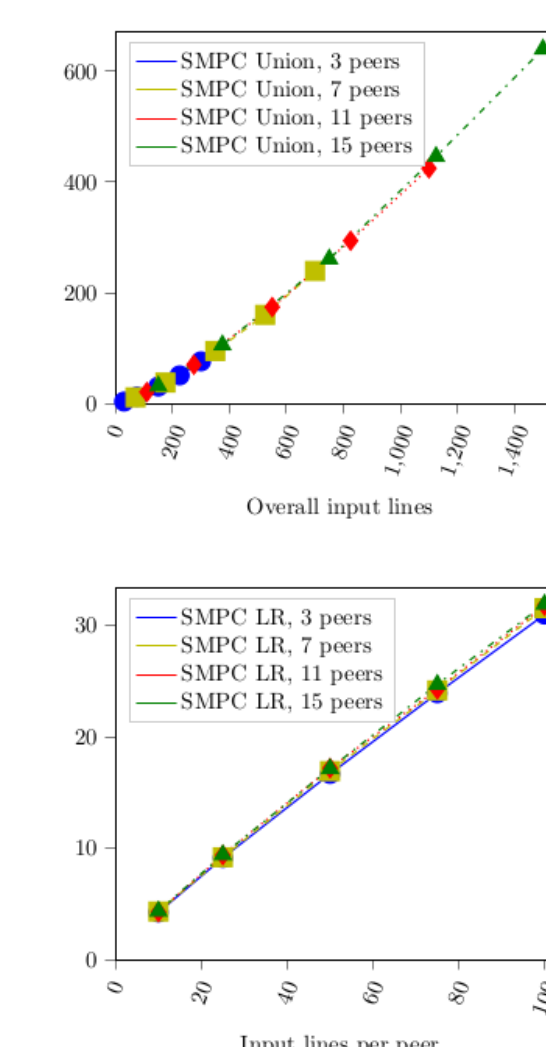
Figure 4. Transmitted data depending on the number of input lines and peers. The graph depicts the number of megabytes transferred between a single pair of hosts in the network. In the secure multiparty computation (SMPC) case, they nearly perfectly correlate with the amount of protocol invocations. LR: